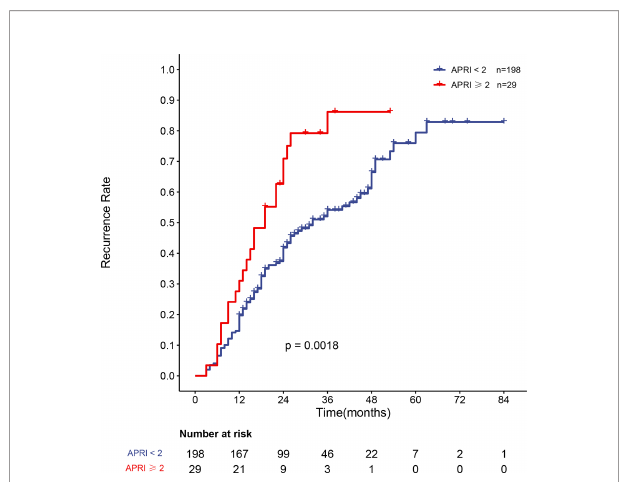
FIGURE 5 | Curve of the recurrence rate of 227 HBV-related sHCC patients with cirrhosis with an APRI <2 and an APRI ≥ 2. HBV, hepatitis B virus; sHCC, small hepatocellular carcinoma; APRI, aspartate aminotransferase-to-platelet ratio index.